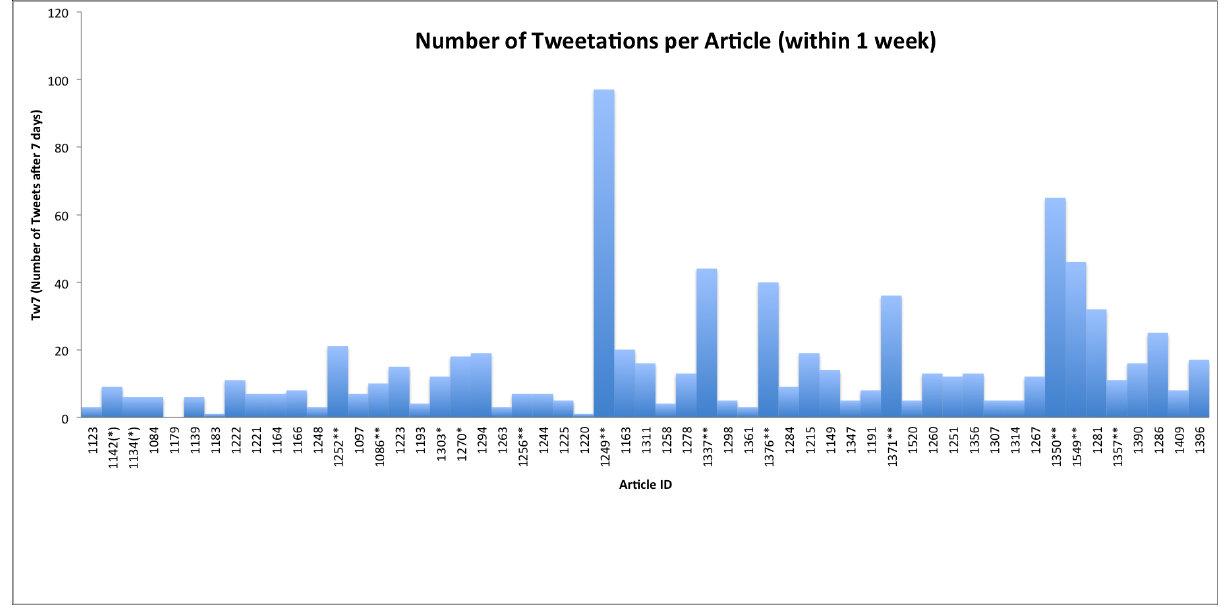
Figure 2. Number of tweetations within 7 days of article publication, per article ID. Asterisks next to article IDs denote that the article is top-cited (see also Figure 8): ** top 25th citation percentile within issue by both Scopus and Google Scholar citation counts * top 25th citation percentile according to Google Scholar only, (*) top 25th citation percentile according to Scopus